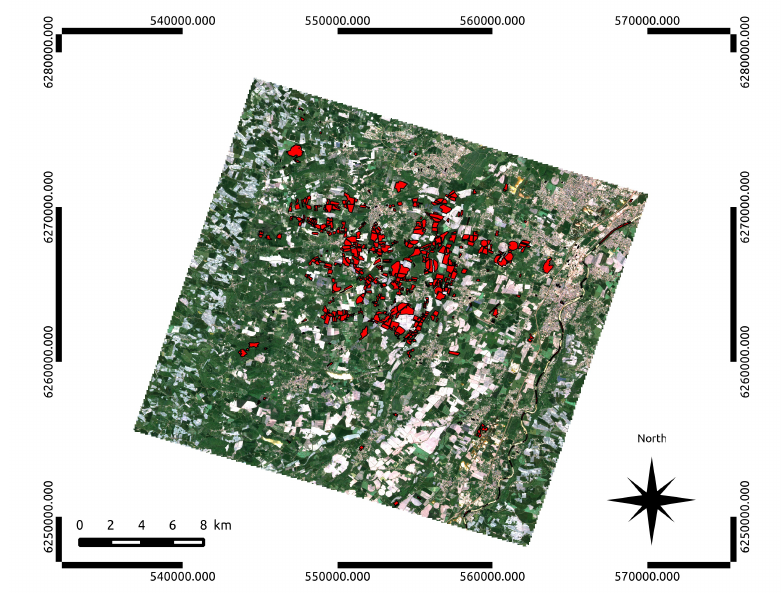
Figure 1. Formosat-2 image of the 6 May 2013 and the corresponding reference data from the field